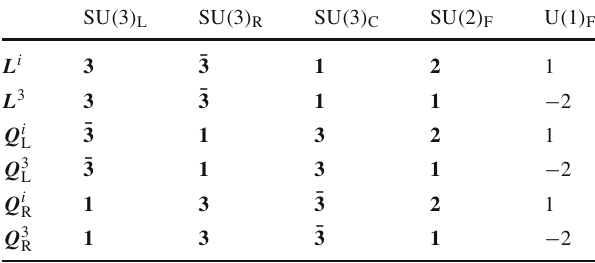
Table 1 Trinification fields representations under [ SU ( 3 ) ] 3 × SU ( 2 ) × U ( 1 ) F F for each of the fundamental chiral superfields shown in Eq.